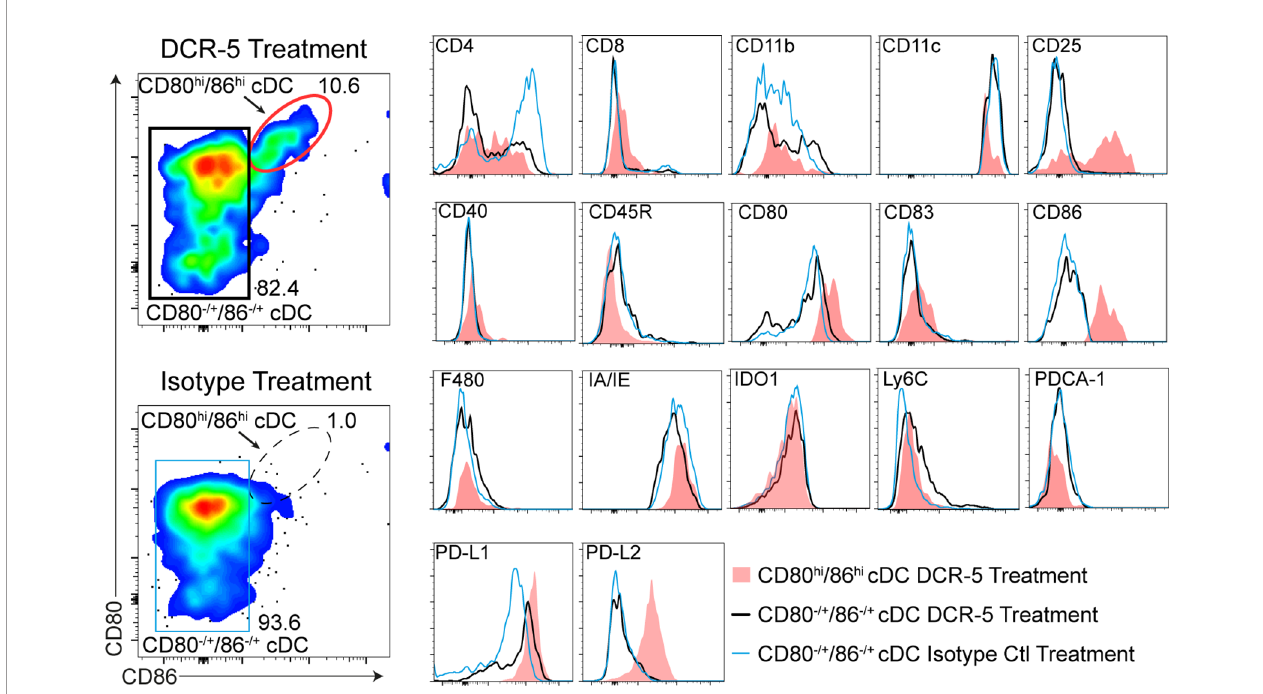
FIGURE 5 | Phenotype of CD80 hi CD86 hi DC population induced by DCR-5 in vivo . Flow cytometric expression of additional markers (histograms on right) on the populations gated in the left plots including the CD80 hi /CD86 hi cDC subset induced after 48 h i.p. treatment with 250 µg DCR-5 antibody (red oval gate) compared to remaining CD80 ± /CD86 ± splenic cDC in DCR-5 (black rectangular gate) or isotype control (blue rectangular gate) treated